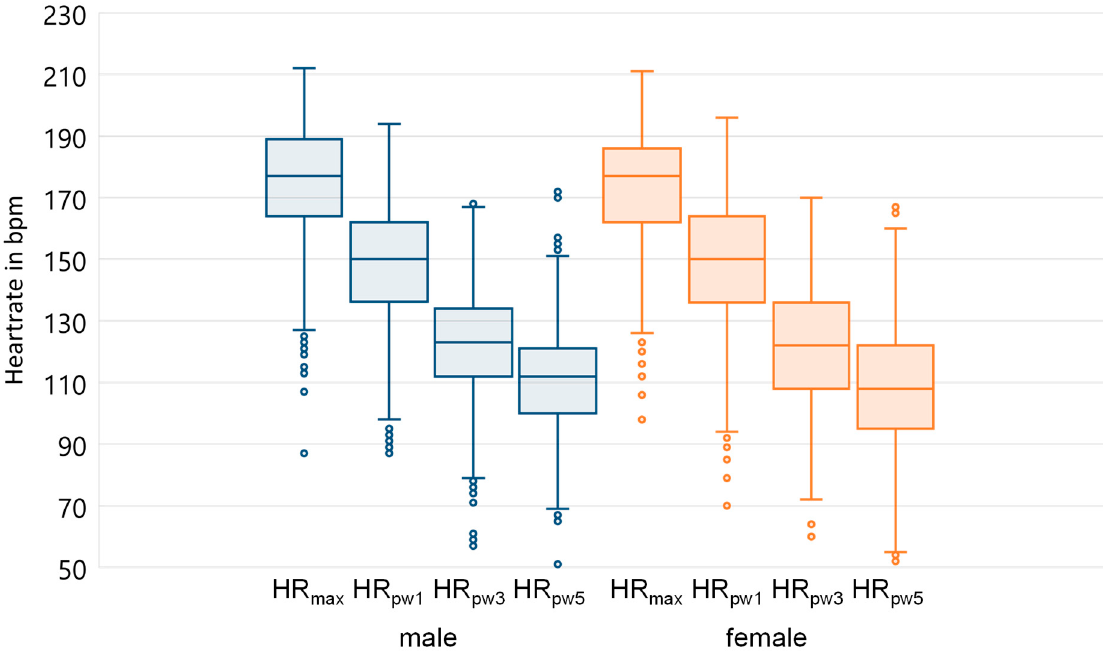
Figure 1. HRR after one, three and five minutes for male and female athletes.